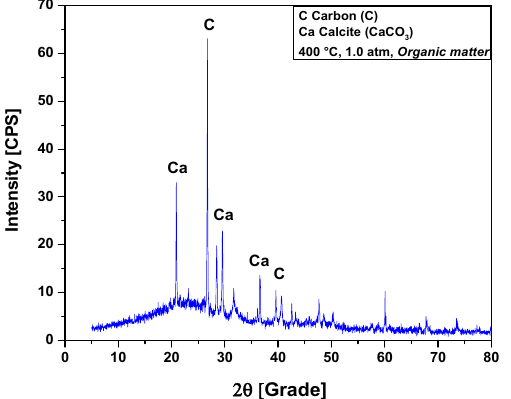
on the position 2 θ : 26.7 (100%), while a peak of low intensity was identified on the position 2 θ : 42.5 (6.7%).